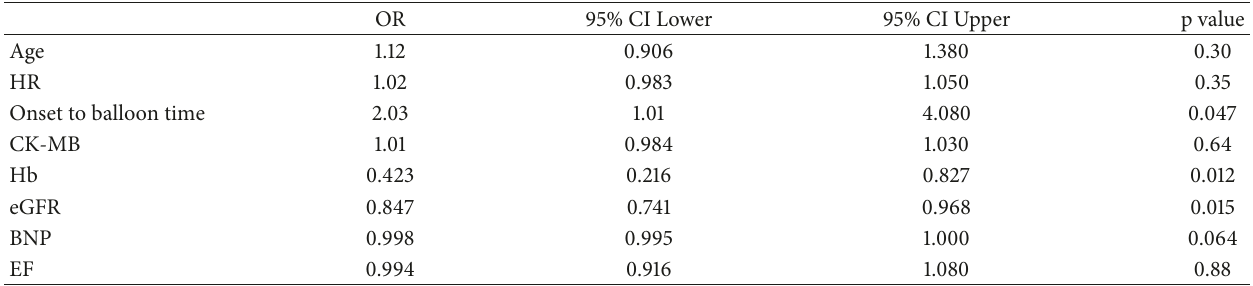
Table 4: Multivariable adjustment of risk factors of late VT/VF.